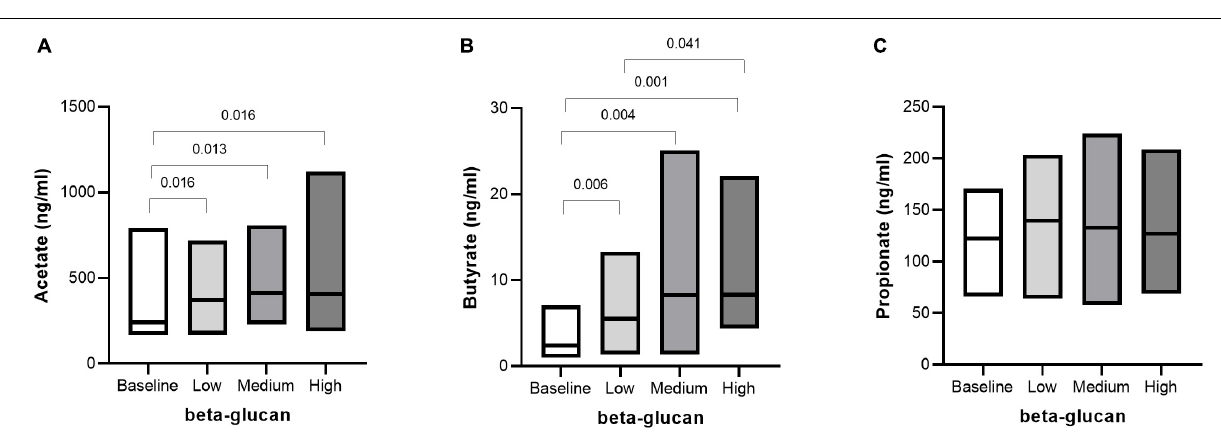
FIGURE 7 | Fasting SCFA after intake of granola with cereal beta-glucan. The fasting levels of Acetate (A) , Butyrate (B) and Propionate (C) at baseline and after consuming low, medium and high amount of beta-glucan for three days. Data is given as median (25 th –75 th ). Significant differences are calculated with Friedman’s Anova followed by Wilcoxon signed rank test and are presented with